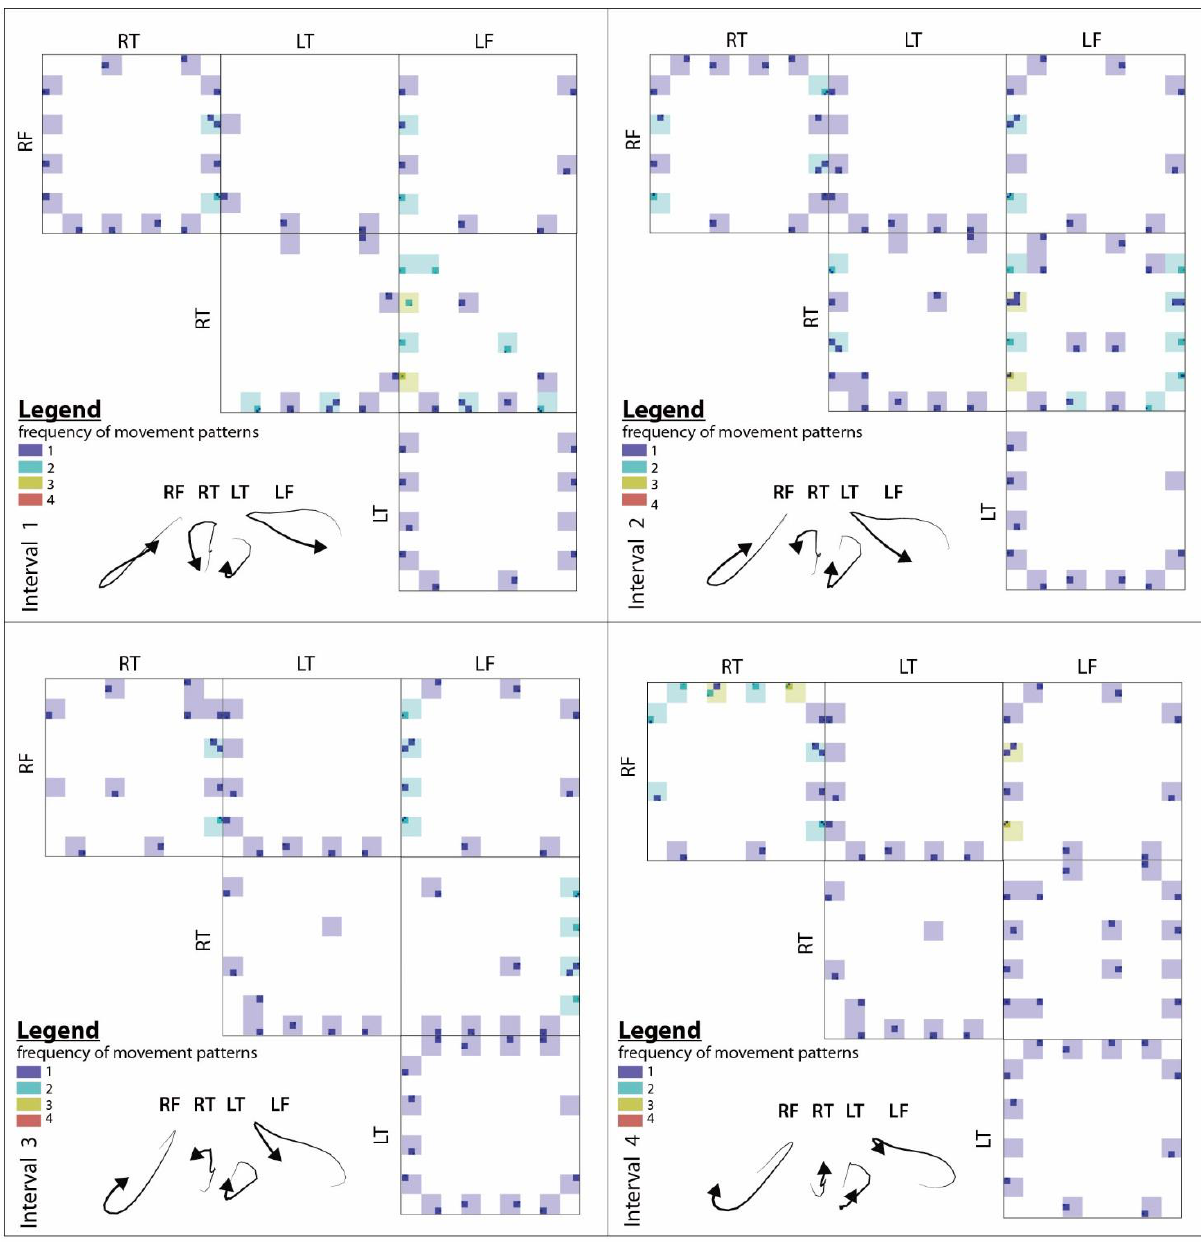
Figure 11. Hyper-SESIs of four equal time intervals of movements based on the frequency of QTC movement B